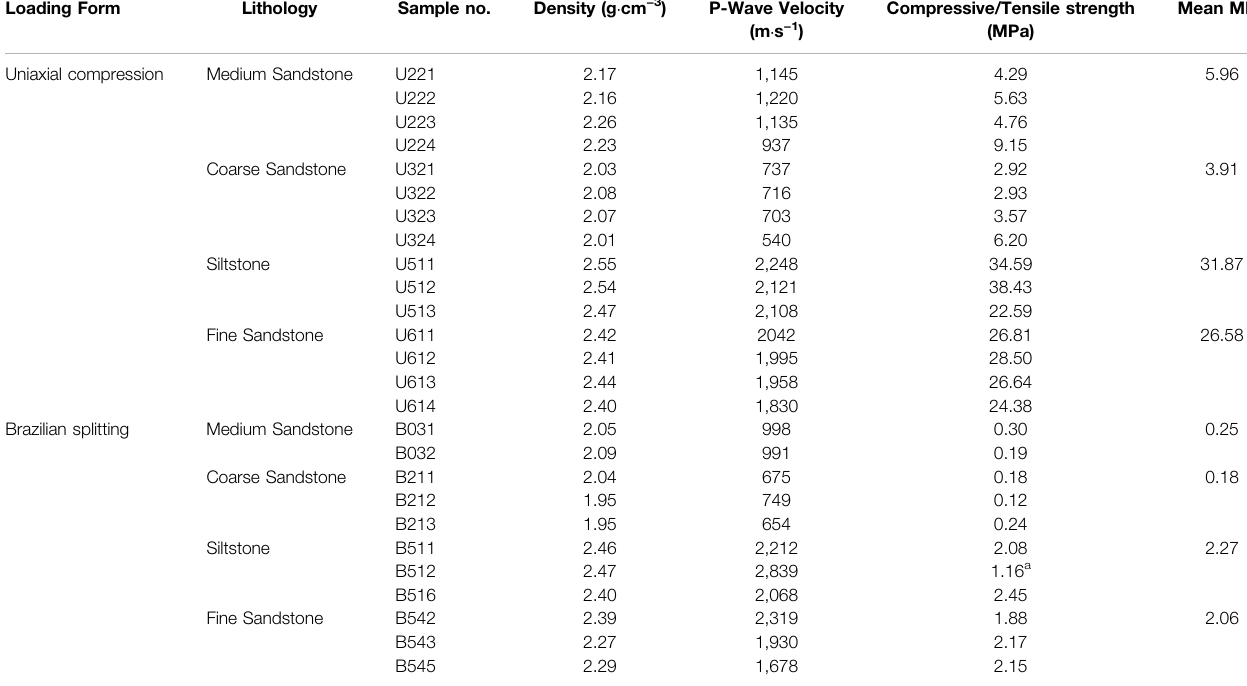
TABLE 1 | Physical and mechanical properties of rock samples. Loading